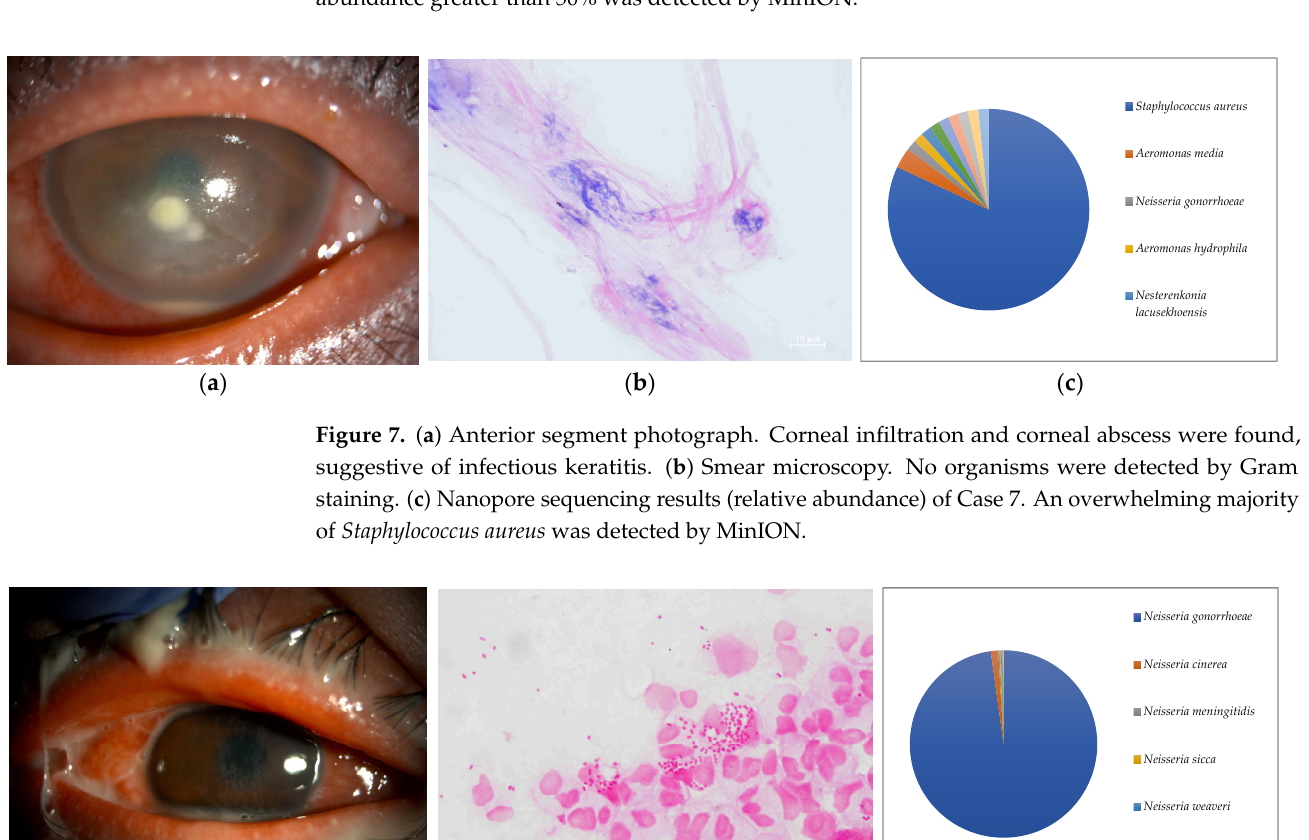
Figure 6. ( a ) Anterior segment photograph. Corneal infiltration and abscess were found in nasal cornea, suggestive of infectious keratitis. ( b ) Smear microscopy. Few Gram-positive rods are detected ( c ) Nanopore sequencing results (relative abundance) of Case 6. No bacterial species with a relative abundance greater than 50% was detected by MinION.